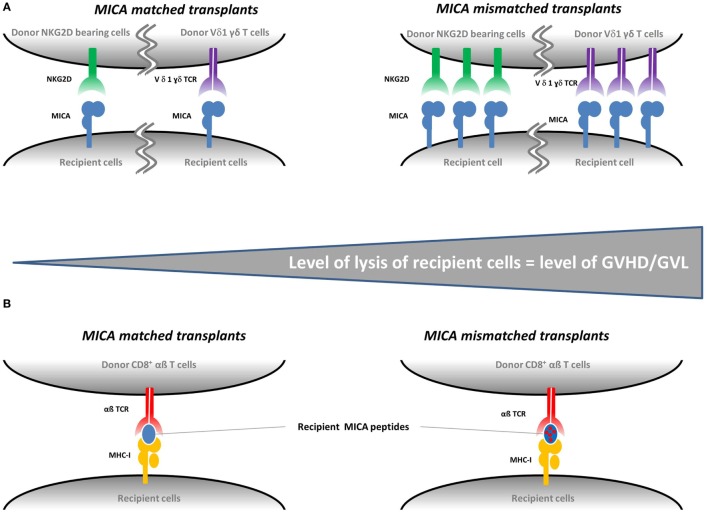
Proposed mechanisms for the role of MICA mismatches in graft-vs.-host disease (GVHD). There are two non-exclusive possible molecular mechanisms involved in the development of GVHD in the context of MICA-mismatched transplants. Panel (A) illustrates how an increased MICA expression—possibly induced by MICA mismatches—could lead to an increased cytolysis of recipient cells mediated by the natural killer group 2, member D (NKG2D) on donor natural killer cells and/or the TCR of donor Vδ1-bearing γδ T cells and/or donor T CD8+ cells as a co-stimulatory function. GVHD and graft-vs.-leukemia (GVL) can be triggered if the target cells of the recipients are healthy or malignant, respectively. Panel (B) illustrates how MICA could act as a minor histocompatibility antigen. If the donor is matched for MICA, the recipient MICA-derived peptides are recognized as «self» by donor cells. If the donor is mismatched for MICA, the presented recipient MICA-derived peptides are recognized as «non-self» and recipient cells are lysed by donor CD8+ T cells.